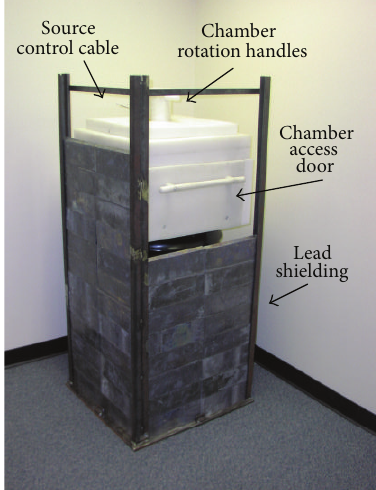
Figure 3: Assembled neutron irradiator with lead shielding. its shielding properties and weight from being filled with a paraffin-lead mixture. A polyvinyl chloride (PVC) pipe with a 10.2 cm ID (10.8 cm OD) runs vertically through the center of the shipping container. The cylinder housing the source fits snug in the PVC pipe and rests at the bottom of the container core, approximately halfway down the drum. The PVC pipe extrudes from the top surface of the drum by almost the same height as the drum edge ( ∼ 10